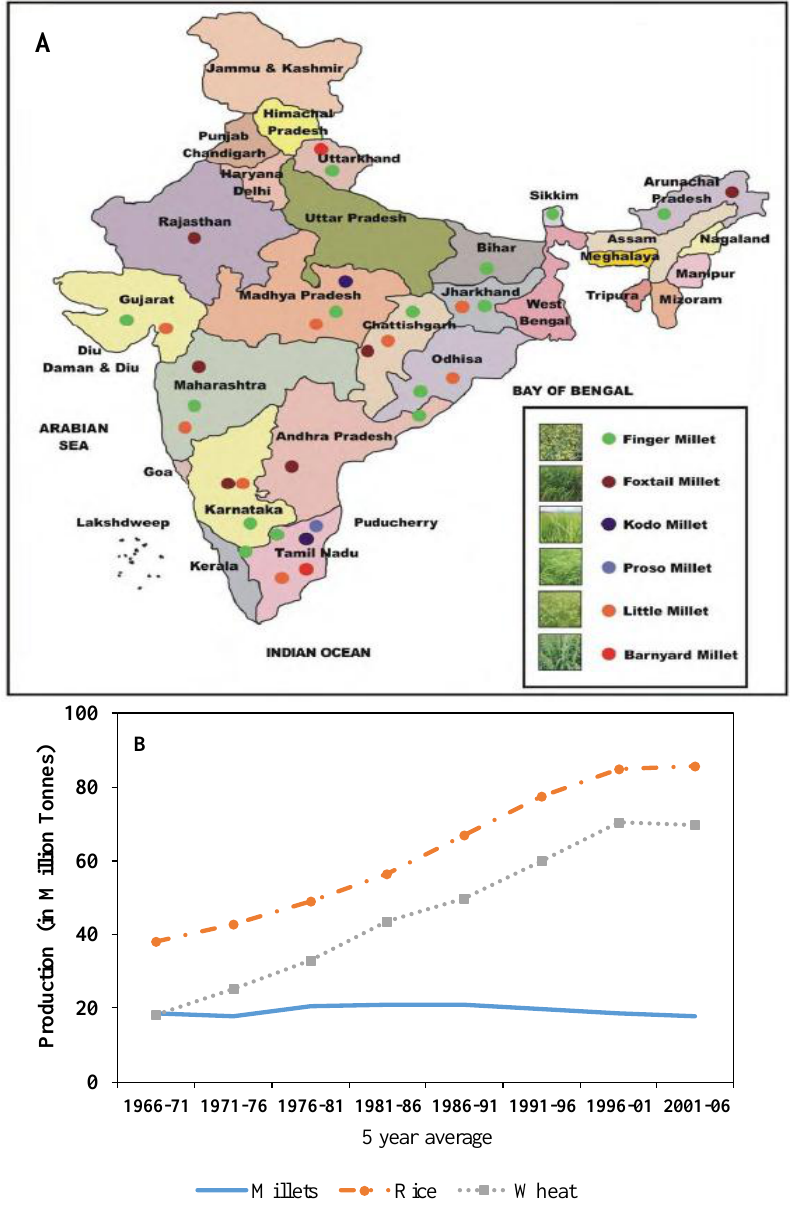
Figure 1. India’s small millets cultivation facts. The distribution of small millets production in India [2] ( A ); Millet production when compared to substitutes ( B ).